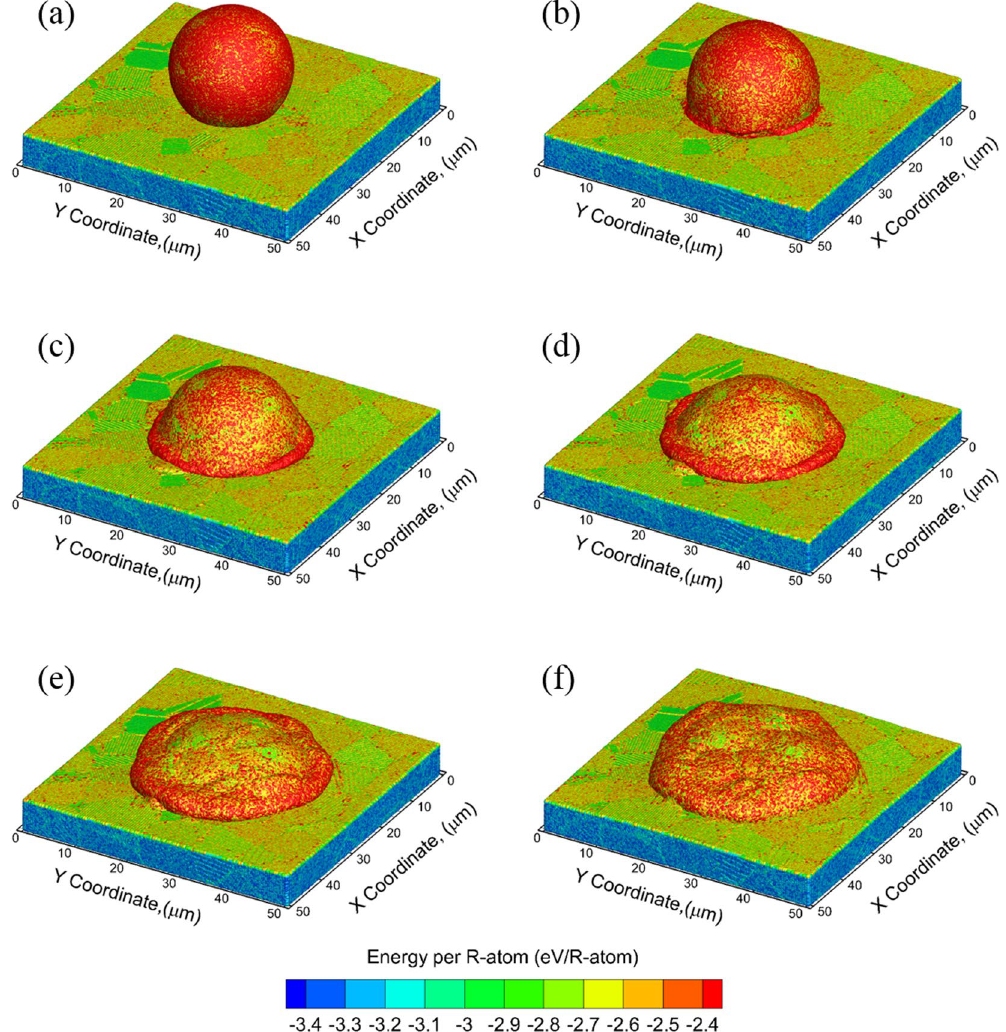
Figure 1. Splat morphology of a single particle impact model with an impact velocity v i = 1600 m/s; snapshots at ( a ) t = 2 ns, ( b ) t = 4 ns, ( c ) t = 6 ns, ( d ) t = 8 ns, ( e ) t = 12 ns, and ( d ) t = 20 ns. The color of the atoms corresponds to the total energy of each R-atom in the QCGD simulations and is the same for all